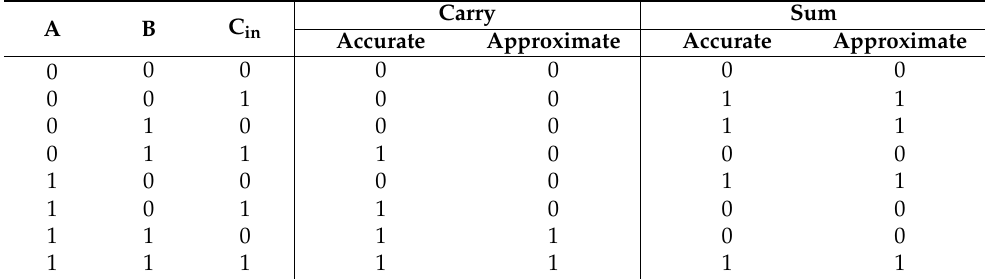
Table 5. Truth table of the accurate full adder and the proposed IMC approximate adder.